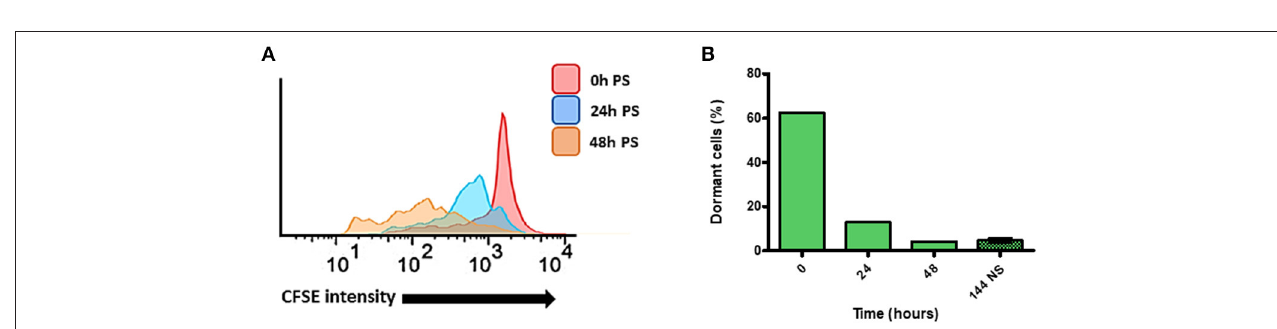
FIGURE 2 | Quantification of dormant replication cells after sorting of dormant epimastigote cells. (A) Flow cytometry histograms of dormant epimastigotes of Bug strain after sorting. Cells sorted (0h post-sorted; PS) were resuspended in fresh medium, and CFSE intensity was followed every 24h until 48h PS. Cells that exhibited similar CFSE intensity at each point when compared to the level of half median of 0h PS were considered arrested cells. (B) The percentage of arrested cells after sorting as detected in flow cytometry histograms in each time point. The percentage of dormant cell before sorting at 144h is presented to